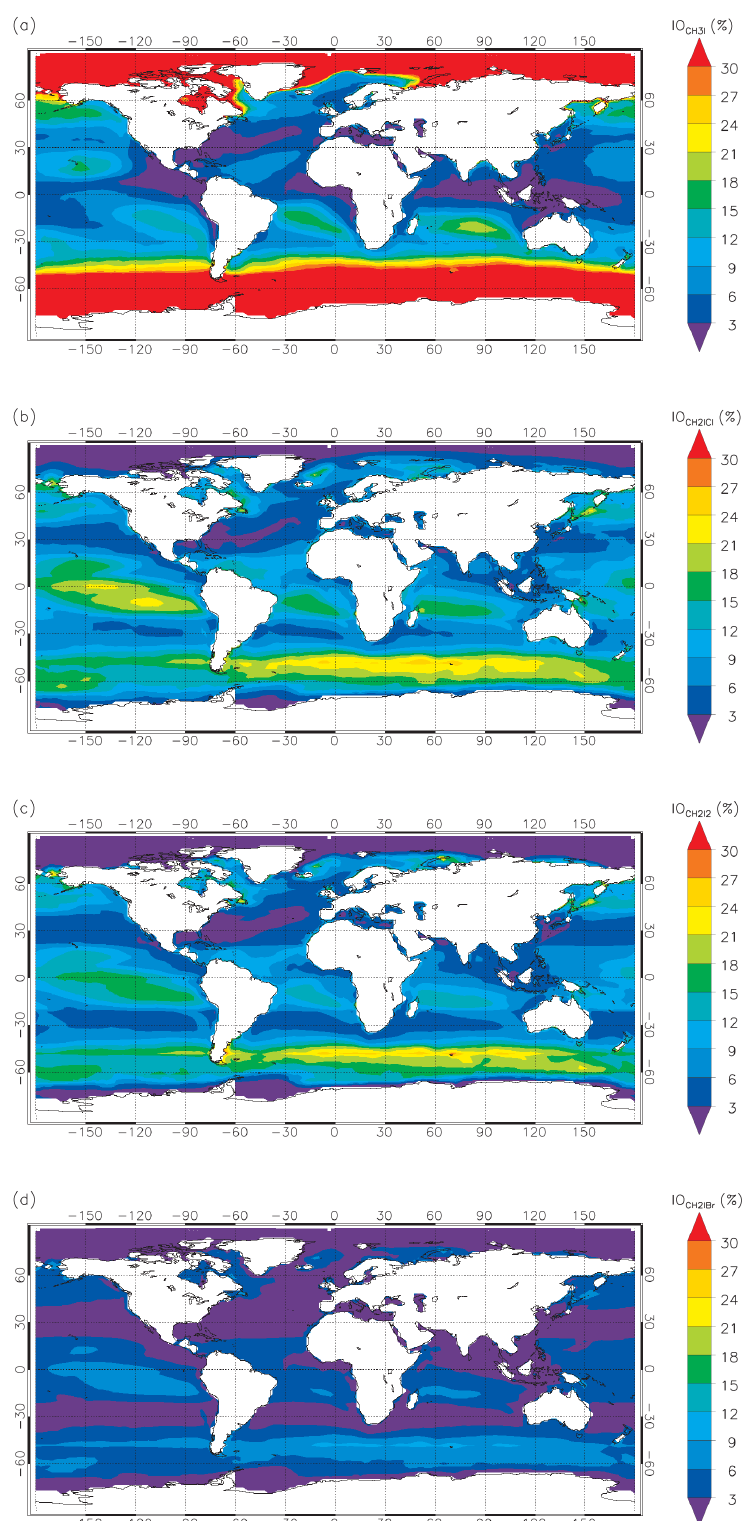
Figure 7. Simulated percentage contribution of the different short-lived iodocarbons – ( a ) CH 3 I, ( b ) CH 2 ICl, ( c ) CH 2 I 2 and ( d ) CH 2 IBr – to the IO budget in the marine environment. Note that, for comparison purposes, the colour code is the same in the four panels. Also note that these model simulations do not include iodine emissions from ice surfaces. For the absolute values of the OSG emissions, please refer to the study of Ordóñez et al.,